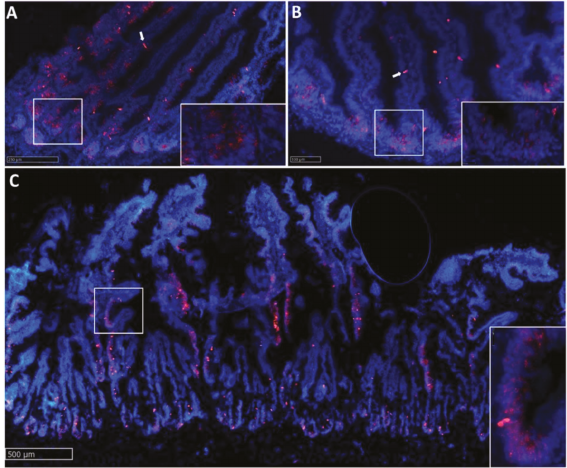
Figure 10. In situ hybridization of sox9 mRNA cells (red dots) in pyloric caeca ( A ), first segment of the mid-intestine ( B ), and second segment of the mid-intestine ( C ). Sox9 + cells were observed in the epithelium lining the fold base in all the investigated districts.The signal in the pyloric caeca, in the second segment of the mid-intestine, and in the basal part of complex folds was stronger compared to that observed in the first segment of the mid-intestine and in the apical part of complex folds. Isolated Sox9 + cells were also observed along the fold length (white arrows).